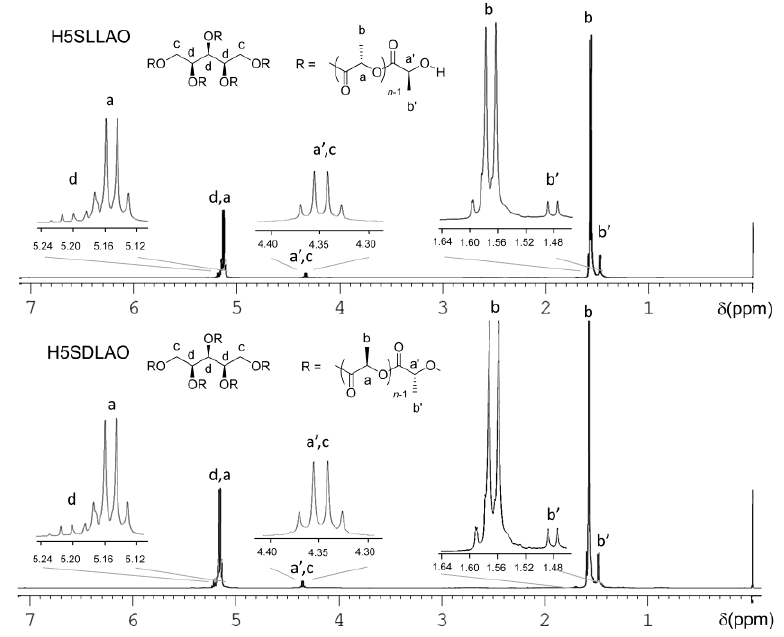
Figure 1. 500 MHz 1 H-NMR spectra of H5SLLAO and H5SDLAO in CDCl 3 .